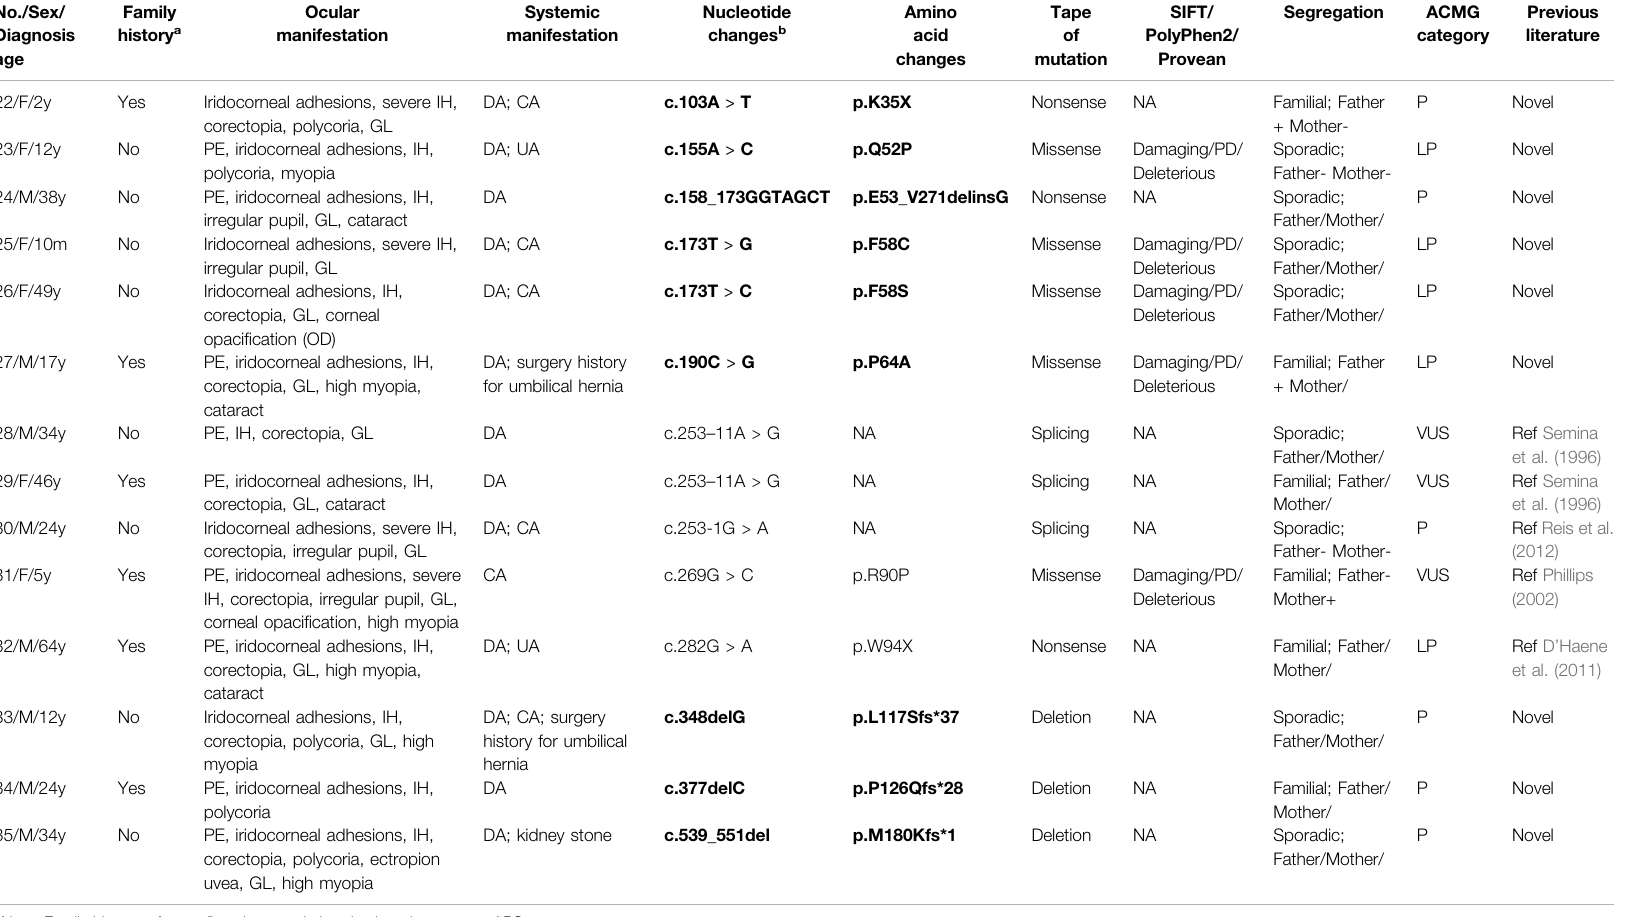
TABLE 2 | The genotype and phenotype of ARS patients with PITX2